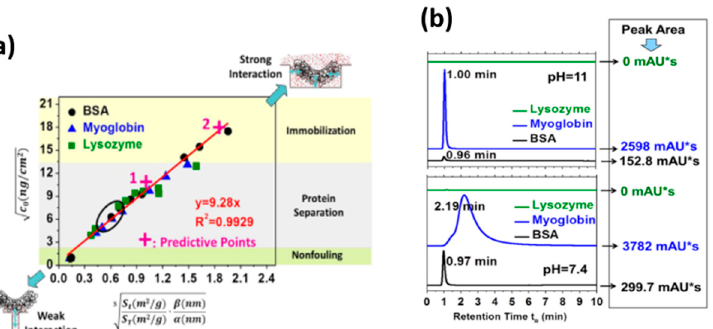
Figure 1. ( a ) A linearly predictive model between the geometry structure of mesoporous TiO 2 and protein adsorptive behavior. ( b ) HPLC measurements of each protein samples after passing through the imprinted home-made TiO 2 column. Reprinted from Ref. [66] with permission from Elsevier.